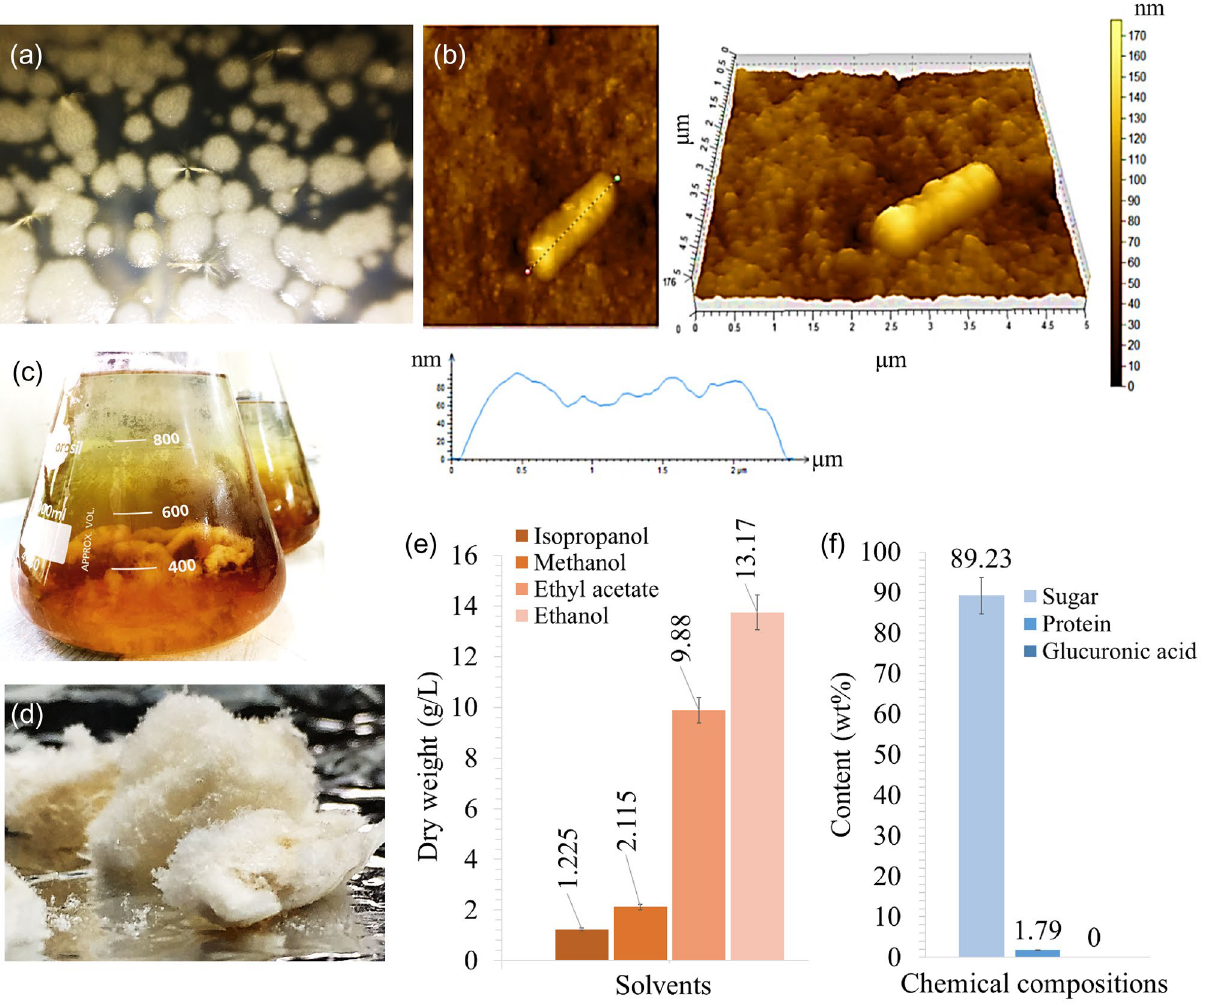
Figure 1. Mature colonies of B . altitudinis SORB11 ( a ); Atomic force micrographs showing cell morphology of strain SORB11 ( b ); EPS precipitation ( c ); lyophilized EPS powder ( d ); production optimization against different solvents ( e ) and chemical compositions ( f ) of the obtained crude